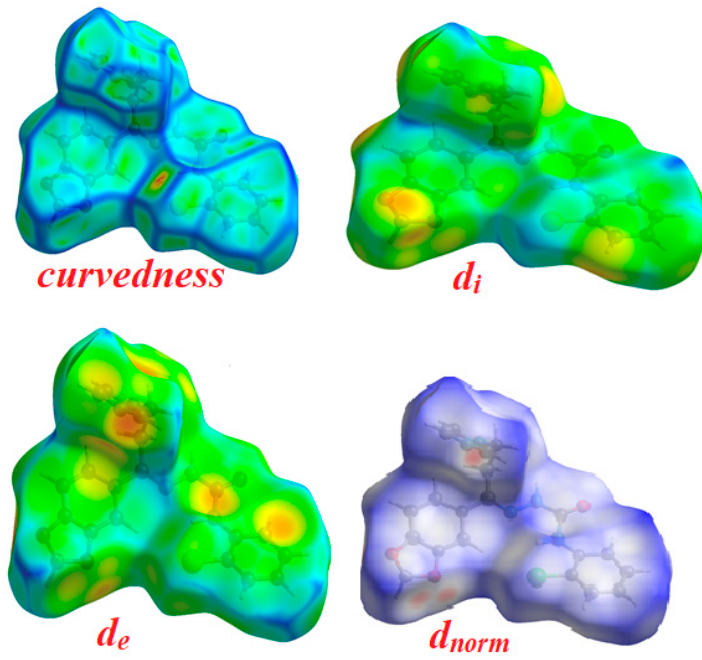
285 Figure 7. Hirshfeld surfaces for d norm , d i , and d e and curvedness for thesemicarbazone 4 .